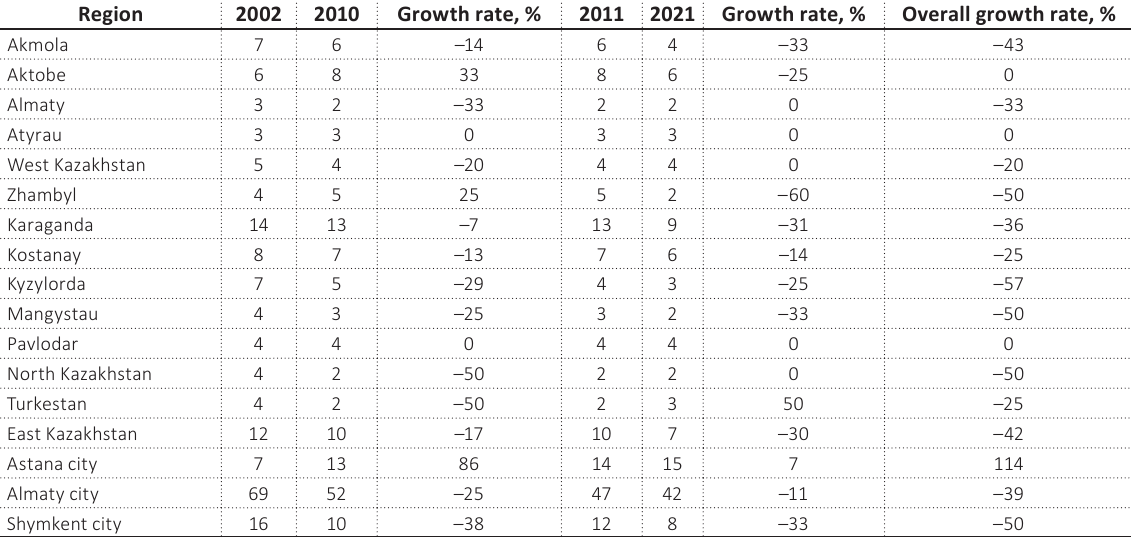
Source: Bureau of National Statistics